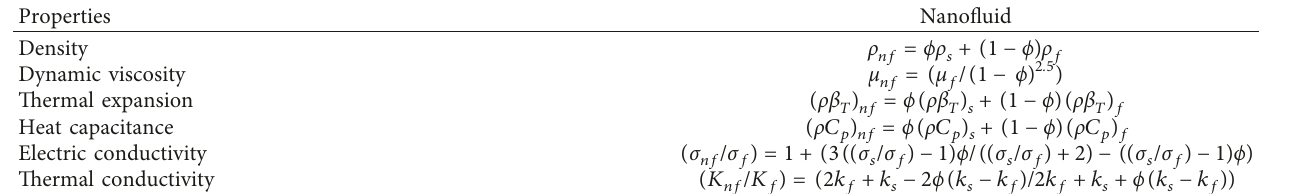
Table 2: Expressions of nanofluid